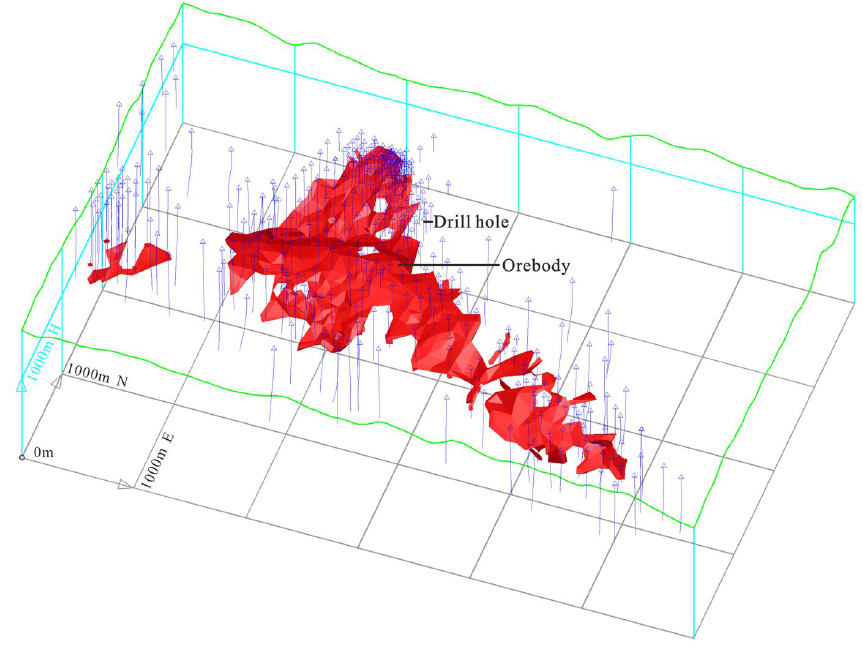
Figure 5. Locations of the drill holes and the ore body model.